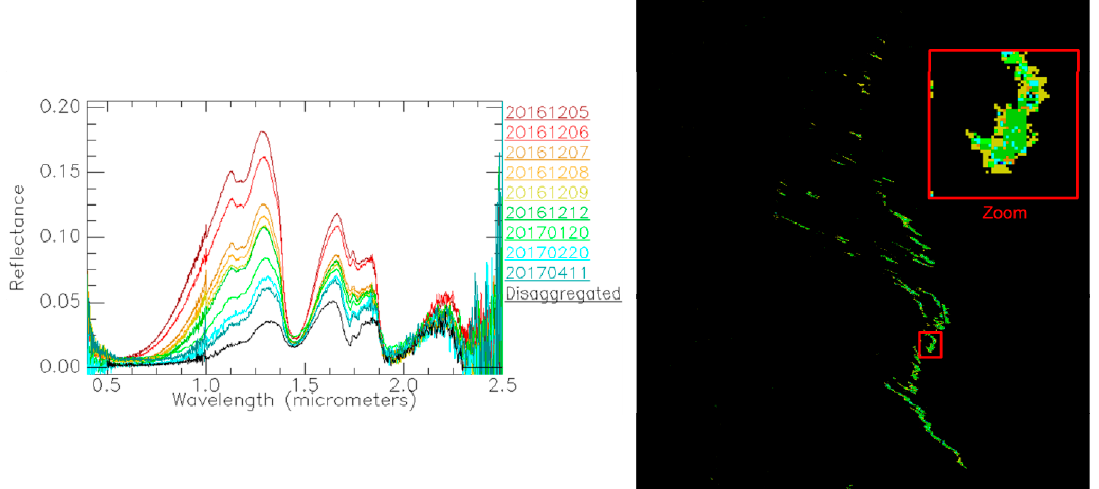
Figure 13. ( Left ) Spectral library of the spectral reflectance between 0.4 and 2.5 µm for the NOFO oil emulsion over time. The “disaggregated” spectrum corresponds to the measurement that was done before reconstructing the emulsion with the mixer. ( Right ) Classification map obtained with the SID approach and the spectral library. The color of pixels follows the color code of the spectral plots.